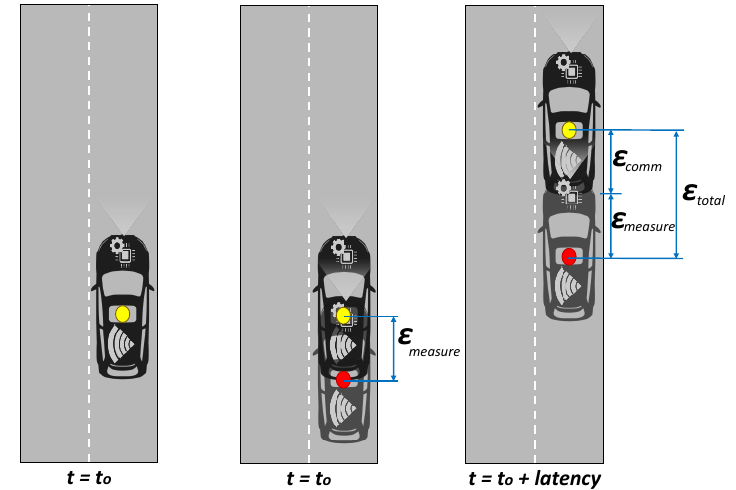
Figure 1. Left to right in the figure: (1) Actual position of the vehicle when the message is sent ( t = t 0 ). (2) Position estimated by the onboard positioning system. This is the position communicated. Note that there is a ε measure longitudinal error. (3) Actual position of the vehicle at t = t 0 + latency . This is the instant in time that the message is received by another vehicle. There is a ε comm error caused by the network latency. The receiver needs to deal with a ε total